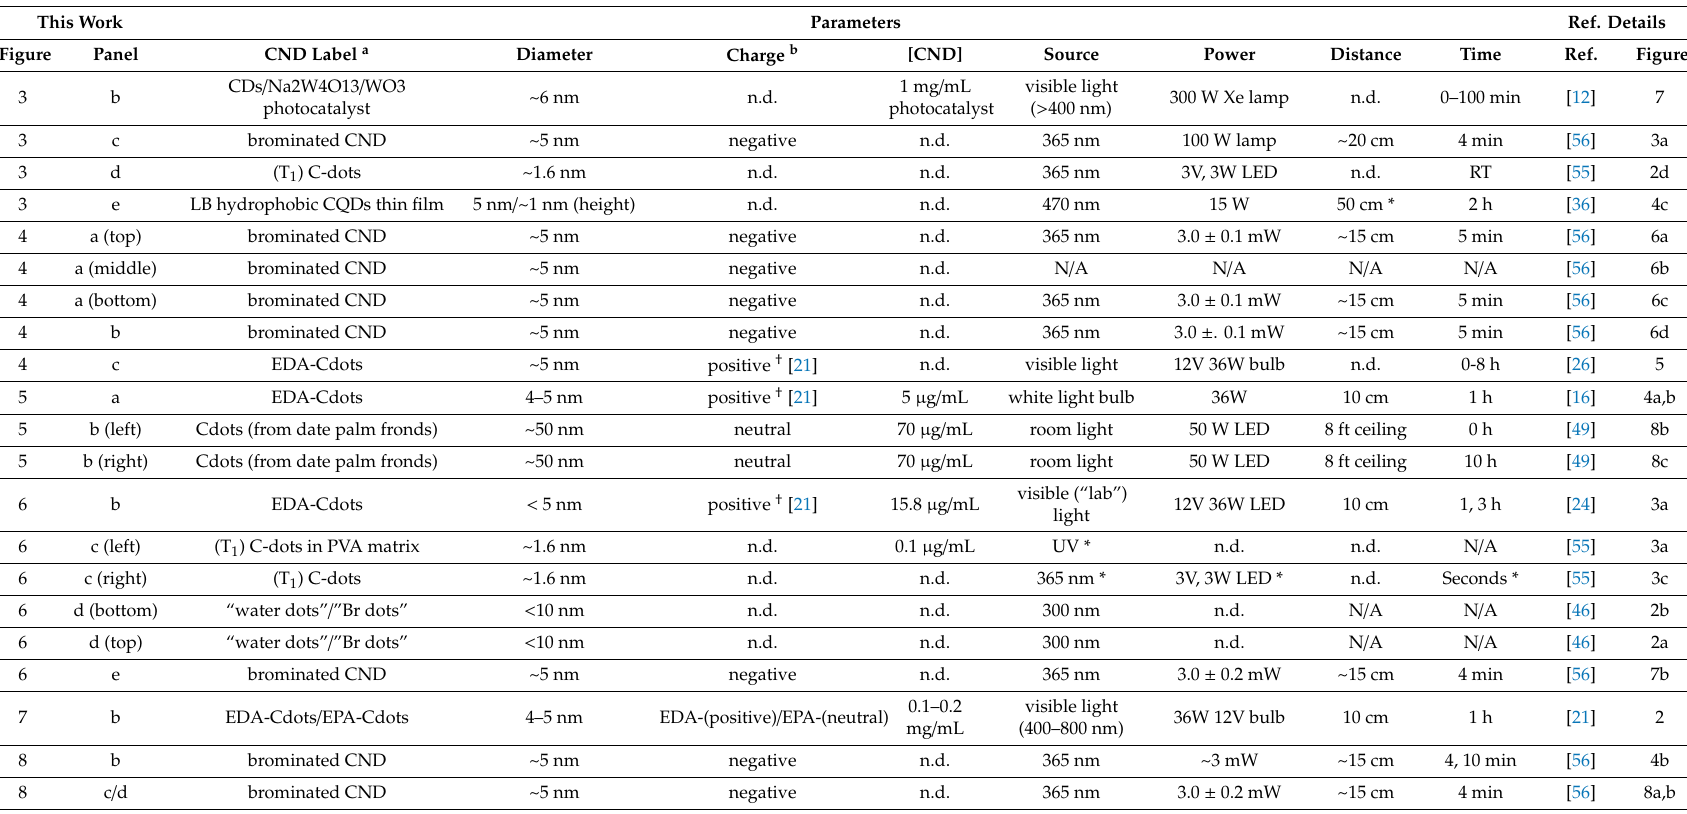
Table 1. Summary of Experimental Parameters for Studies Appearing in Figures for Section 3: Carbon Nanodots as Photodynamic Antimicrobial